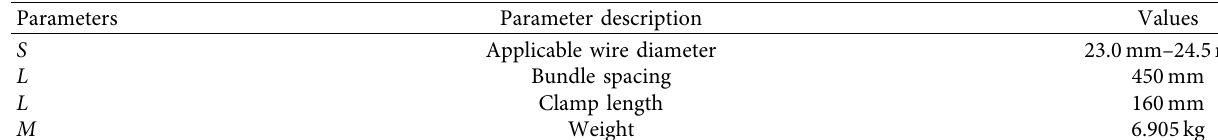
Figure 10: Te new quad-bundle spacer damper physical and dimensional diagram: (a) physical diagram and (b) dimensional diagram. Table 2: Parameters of the new type of quad-bundle spacer damper.